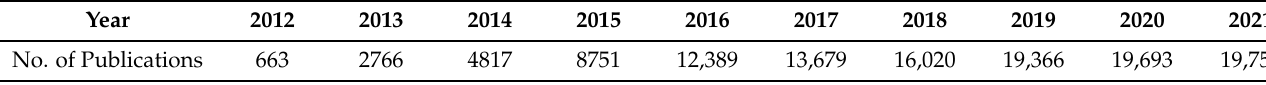
Table 1. The number of research publications per year in the area of Big Data.